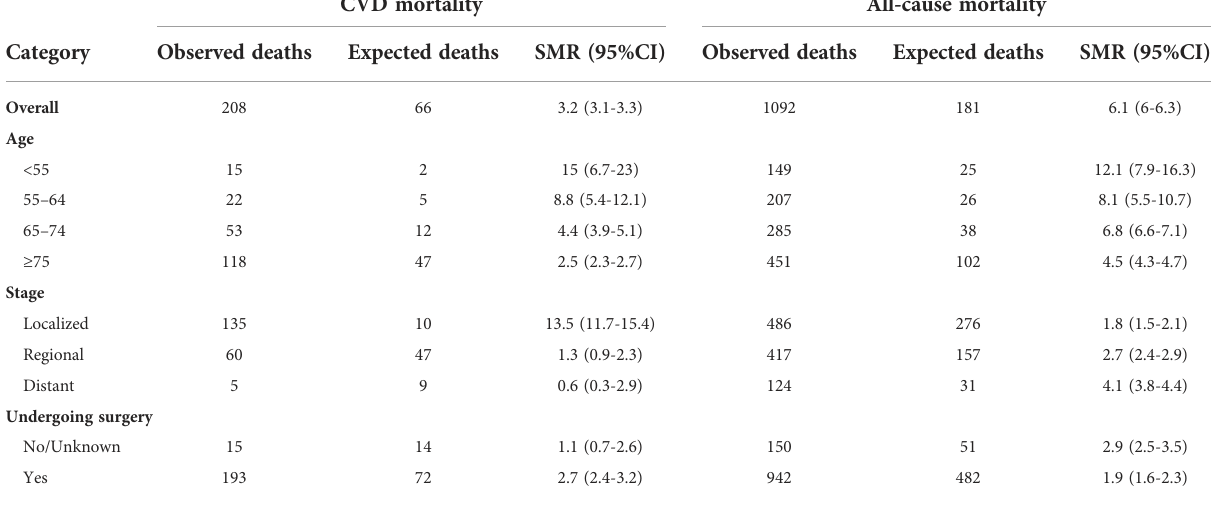
TABLE 2 The CVD-speci fi c and all-cause mortality rates of patients with PSCC were standardized by age, surgery and cancer stage relative to the general population of the United States. CVD